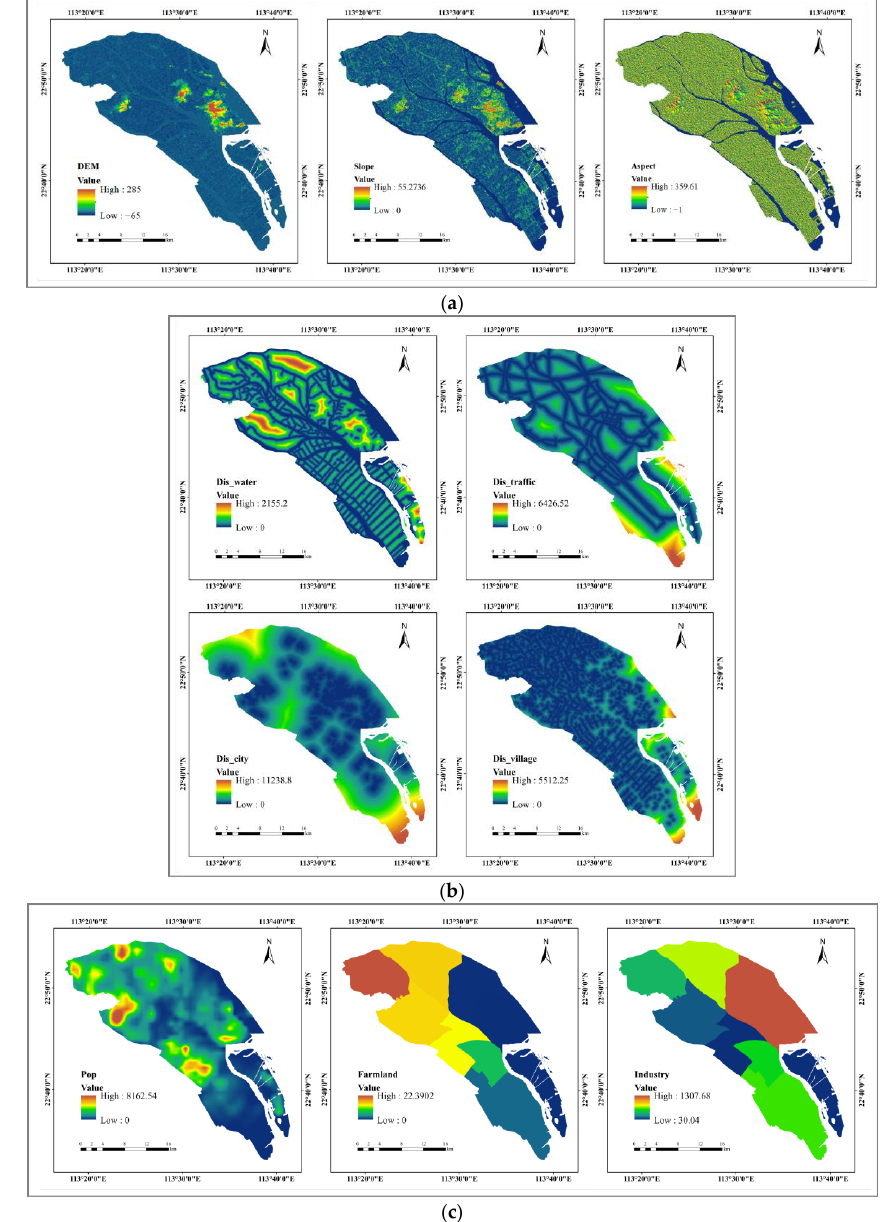
Figure 3. The main driving factors of land use change in Nansha District in 2019: ( a ) Natural factors; ( b ) Distance factors; ( c ) Socioeconomic factors.